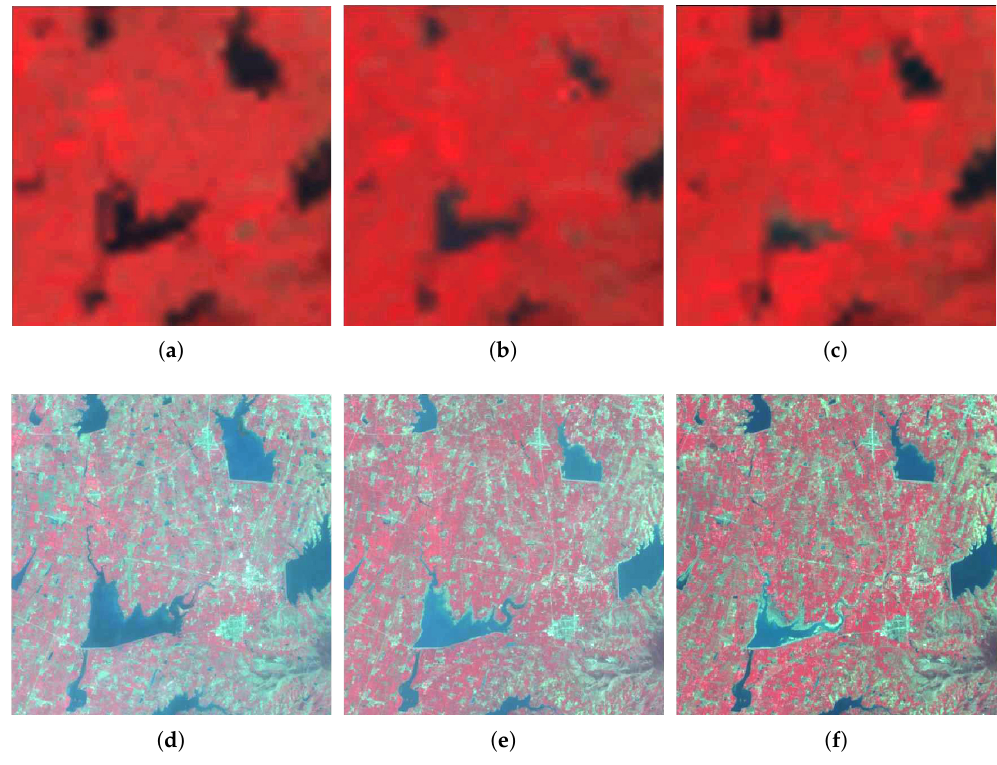
Figure 8. Remote sensing data with type changes: ( a ) MODIS image on 7 April 2001; ( b ) MODIS on 7 April 2002; ( c ) MODIS on 15 April 2003; ( d ) Landsat on 8 April 2001; ( e ) Landsat on 11 April 2002; ( f ) Landsat on 15 April